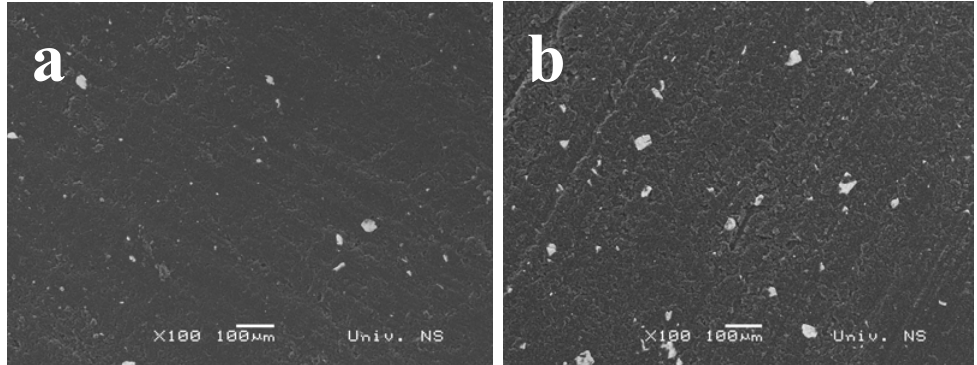
Figure 6. Scanning electron micrographs of Bi5-TCP-CPE ( a ) and Bi20-TCP-CPE ( b ) taken at a magnification of 100×.